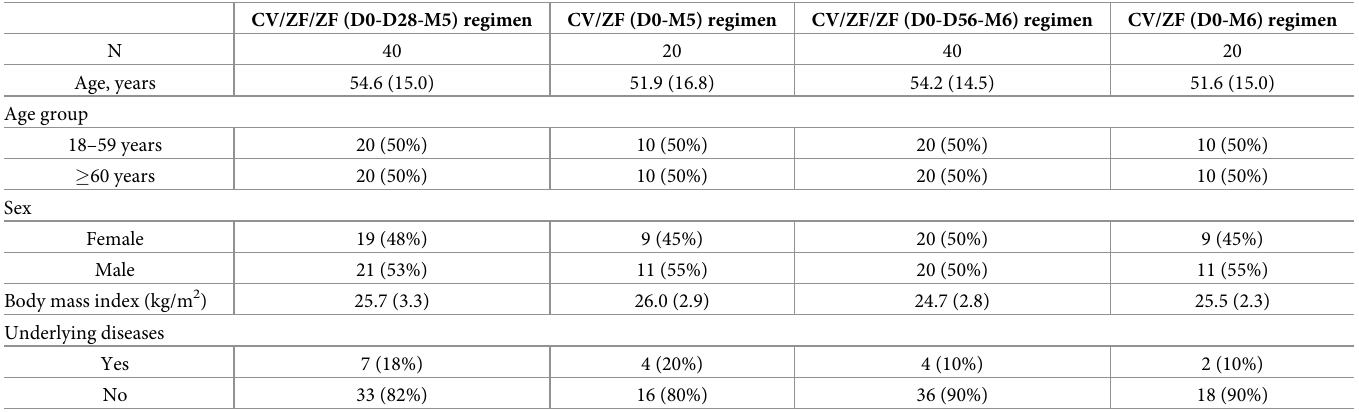
Table 1. Baseline characteristics of the participants by vaccination